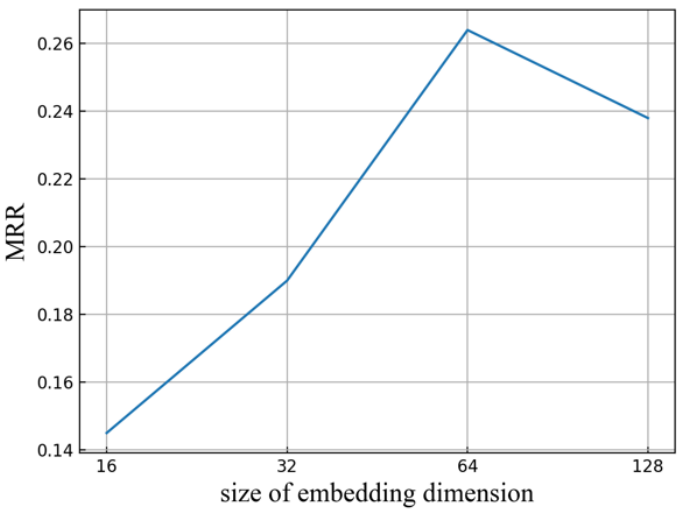
Figure 7. The impact of different embedding dimensions on the JingDong